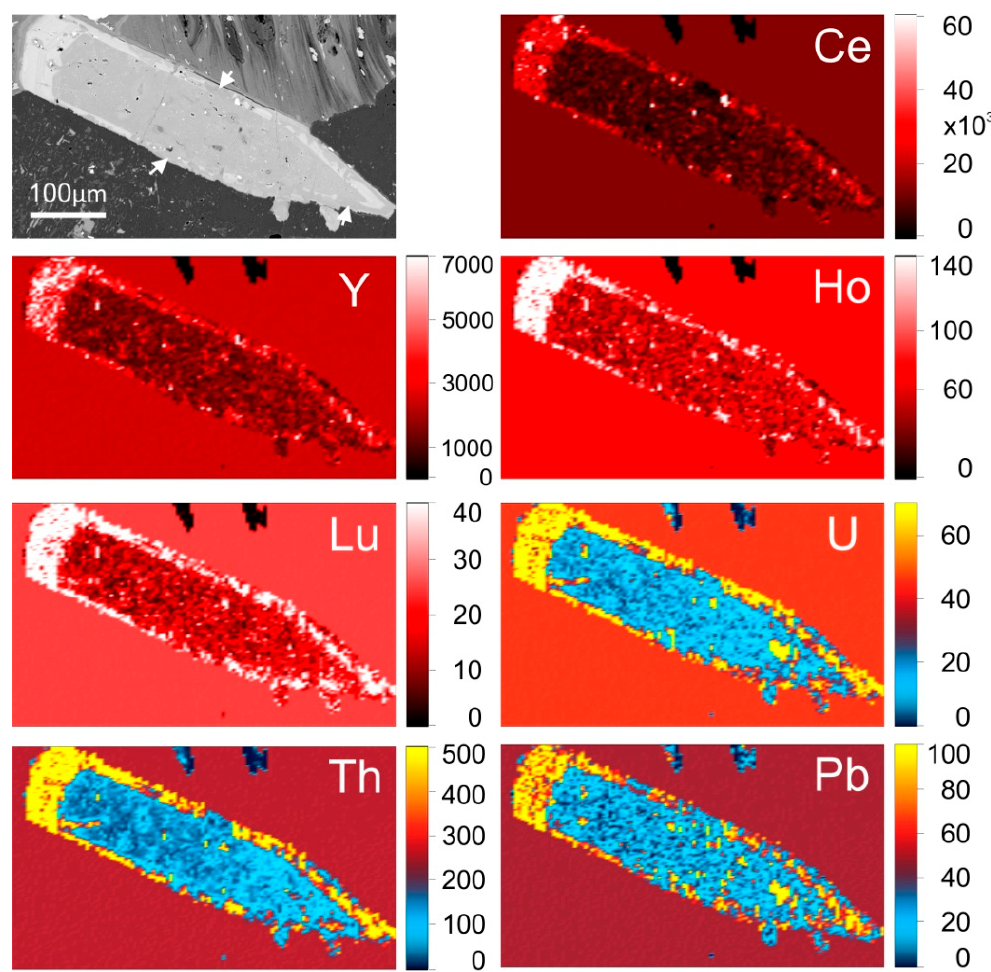
Figure 7. LA-ICP-MS map of a partially altered magmatic apatite grain hosted in hematite-sericite altered RDG (sample 2280-3, Figure 1, Table 1) showing a magmatic, inclusion-rich core and a REY- and U–Th–Pb-enriched rim, both of which have been affected by REY-depletion along fractures and the grain rim marked by the white arrows on the SEM image. All scales are in ppm.